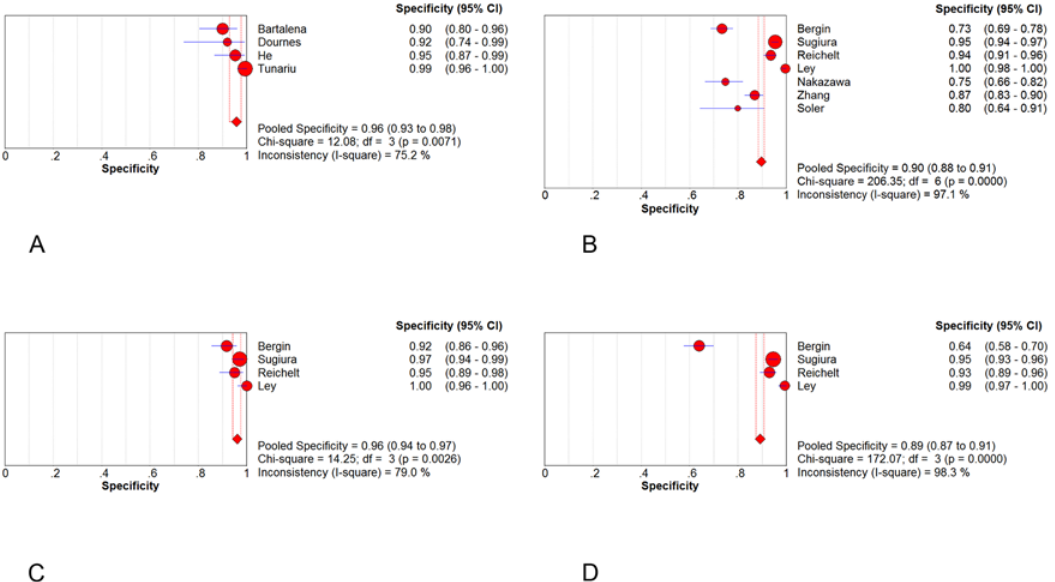
Fig 4. Forest plots of specificity. Specificity in (A) patient basis; (B) total arteries; (C) main + lobar arteries; (D) segmental